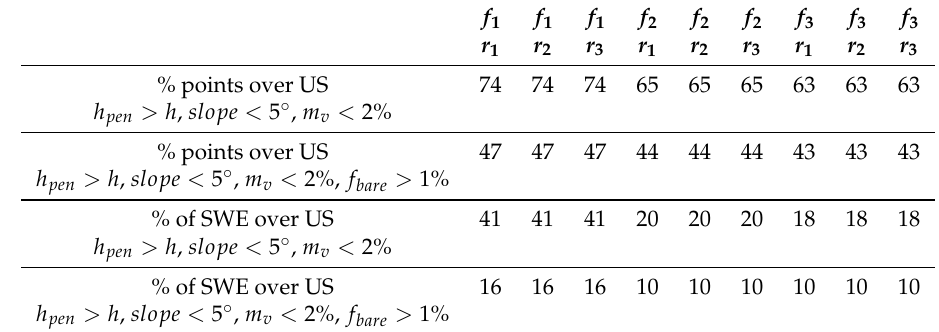
Table 2. US data satisfying the precondition of the dual-pol. dual-freq. retrieval method in 2015, ( f 1 = 1 GHz, f 2 = 13.5 GHz, f 3 = 17.25 GHz , r 1 = 0.2 mm, r 2 = 0.5 mm, r 3 = 0.8 mm. f 1 f 1 f 1 f 2 f 2 f 2 f 3 f 3 f 3 r 1 r 2 r 3 r 1 r 2 r 3 r 1 r 2